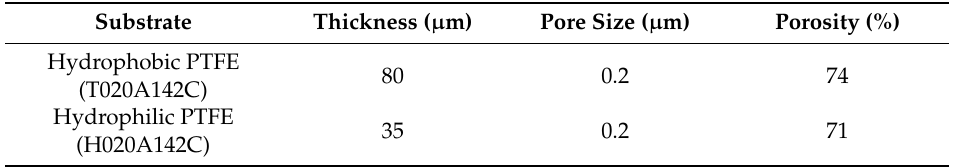
Table 1. Specifications of two porous polytetrafluoroethylene (PTFE) substrates utilized for preparing pore-filled anion-exchange membranes (PFAEMs) in this